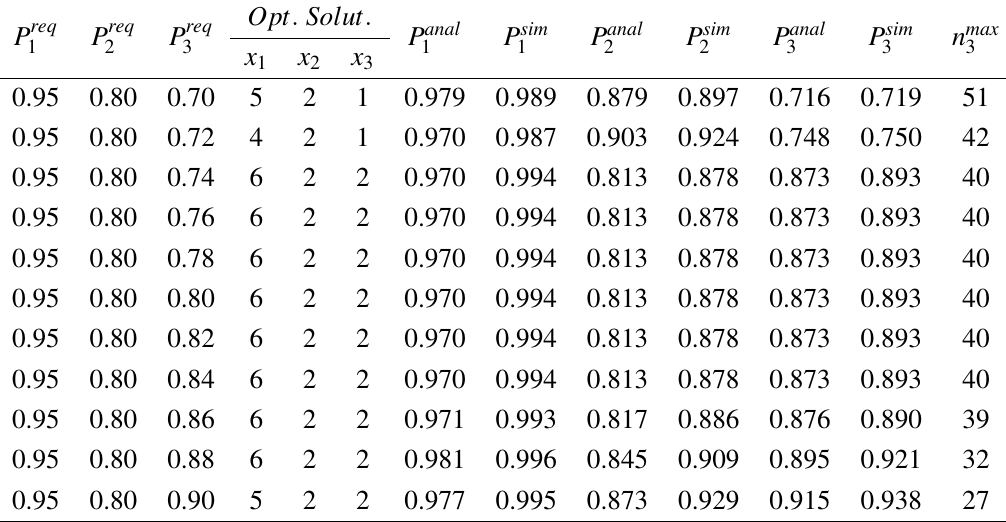
on the PDR achieved from 3